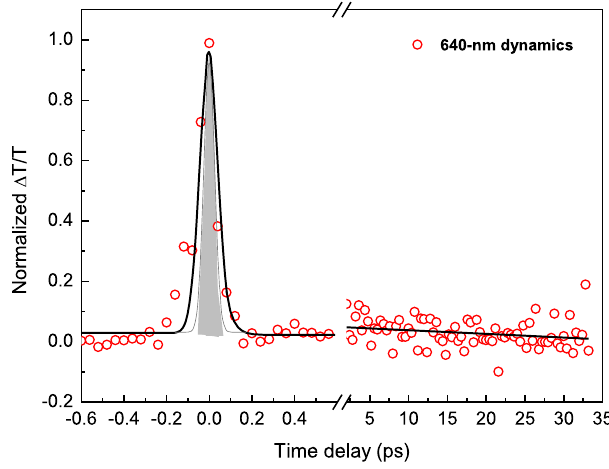
Fig. 5 Ultrafast response of the coupled system. Normalized ultrafast transmittance of the ESC system under a 640 nm optical illumination. The gray area shows the pulse intensity pro fi le (in arbitrary unit).